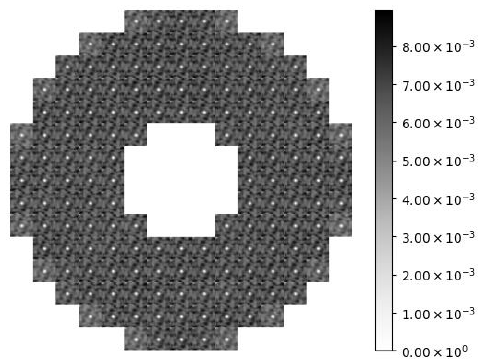
Figure 3. Image of the cross-correlations calculated by the SHWFS from a randomly chosen sample of the training dataset. A spot is situated approximately in the center of each subaperture that corresponds to the maximum of the